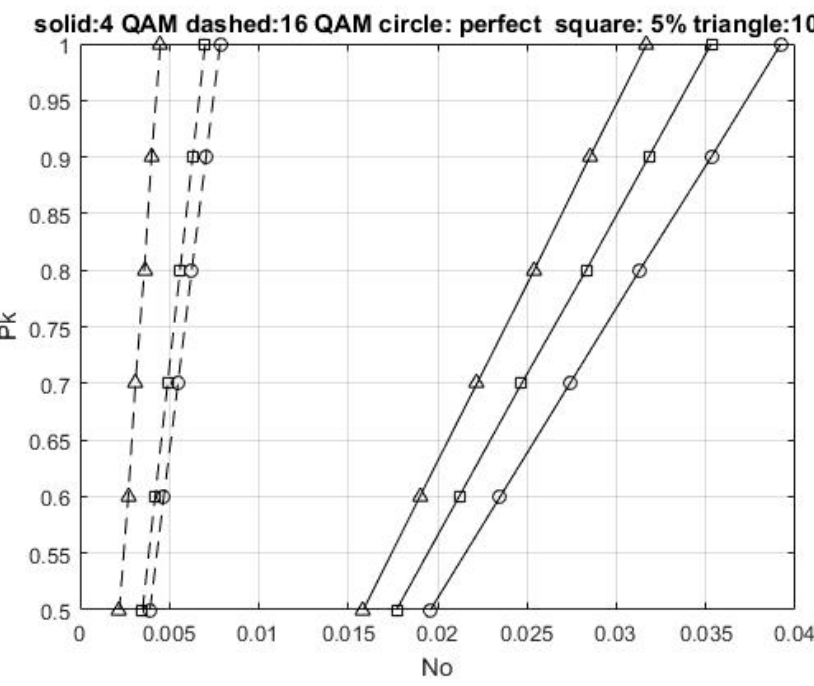
Figure 3. Transmission power weighting of the UFMC-based underwater transceiver with an LDPC code and a BER of 4 104 − × , for PCE and CEEs of 5% and 10%.